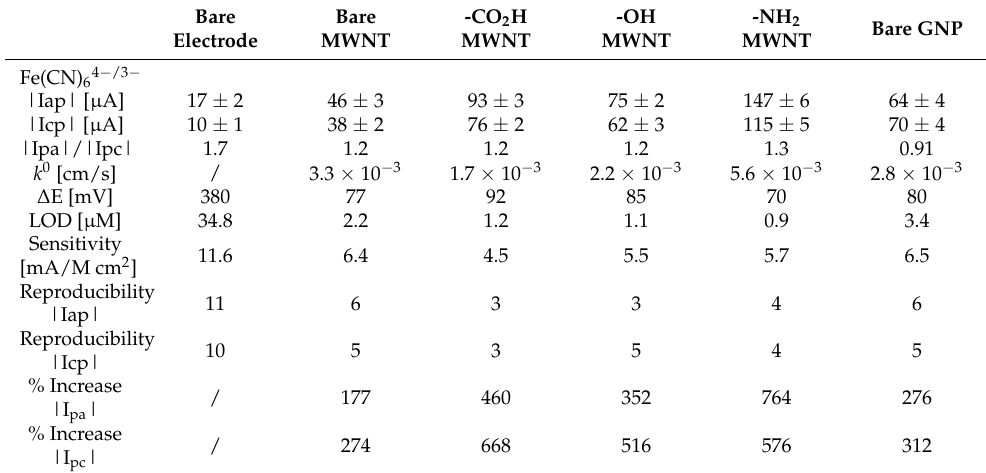
Table 2. Cathodic and anodic peak current intensity, ratio of the anodic and cathodic peak current intensity, electron transfer rate constant (k 0 ), peak-to-peak separation ( ∆ V), LOD, sensitivity, repro- ducibility (RSD%), and percentage increase estimated for bare and nanomaterial-modified SPEs have been reported. All analytical parameters are obtained from cyclic voltammogram traces. Bare Bare -CO 2 H -OH -NH 2 Bare GNP MWNT Electrode MWNT MWNT MWNT Fe(CN) 64 − /3